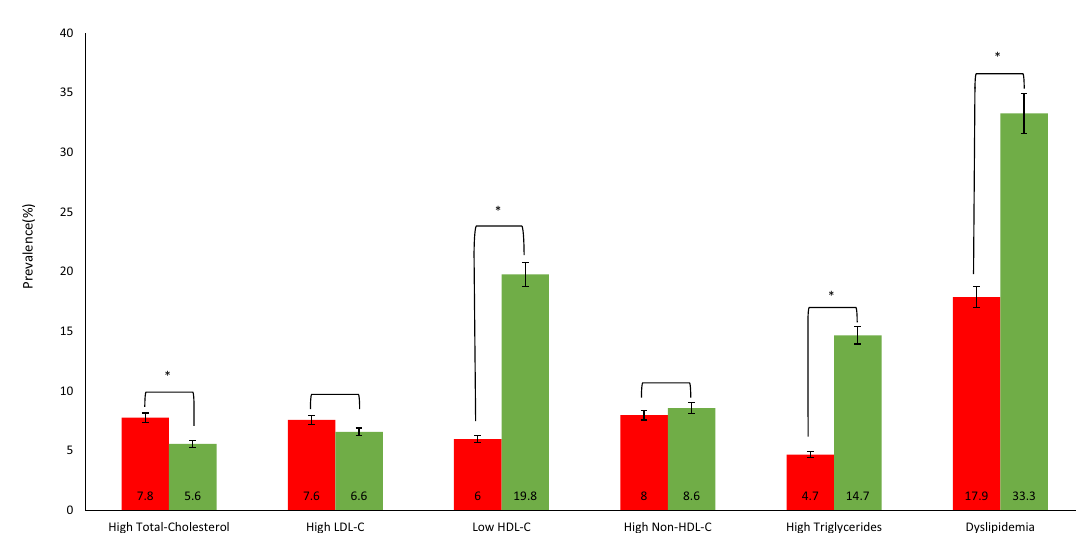
Figure 1. Prevalence of abnormal lipid parameters by to gender. Abbreviations: HDL-C, high-density lipoprotein cholesterol; LDL-C, low-density lipoprotein cholesterol. (*): significant p value.